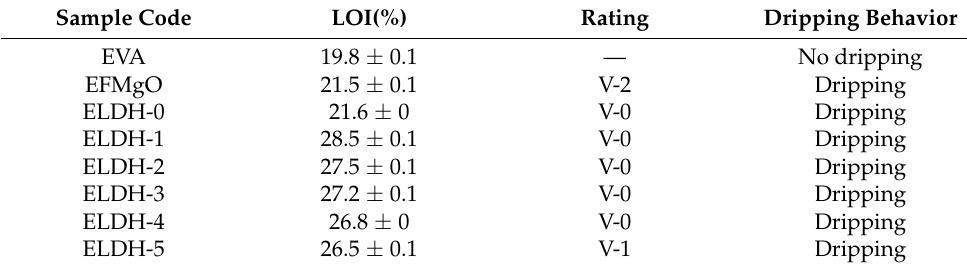
Table 3. LOI values and UL-94 results for EVA/LDHs composites.